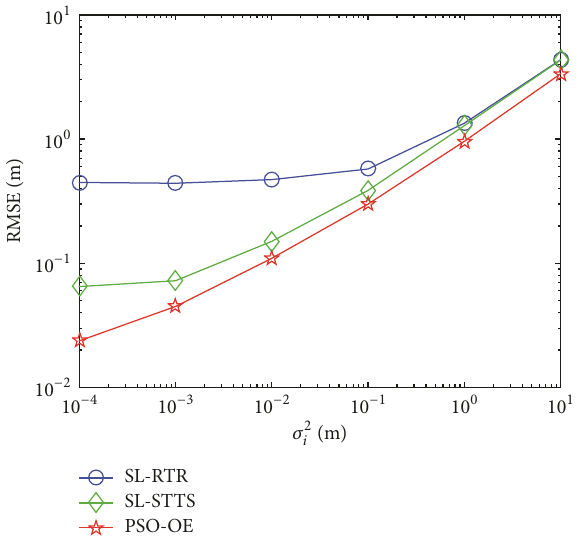
Figure 9: RMSE versus variance of distance measurement noise, where two transponders are